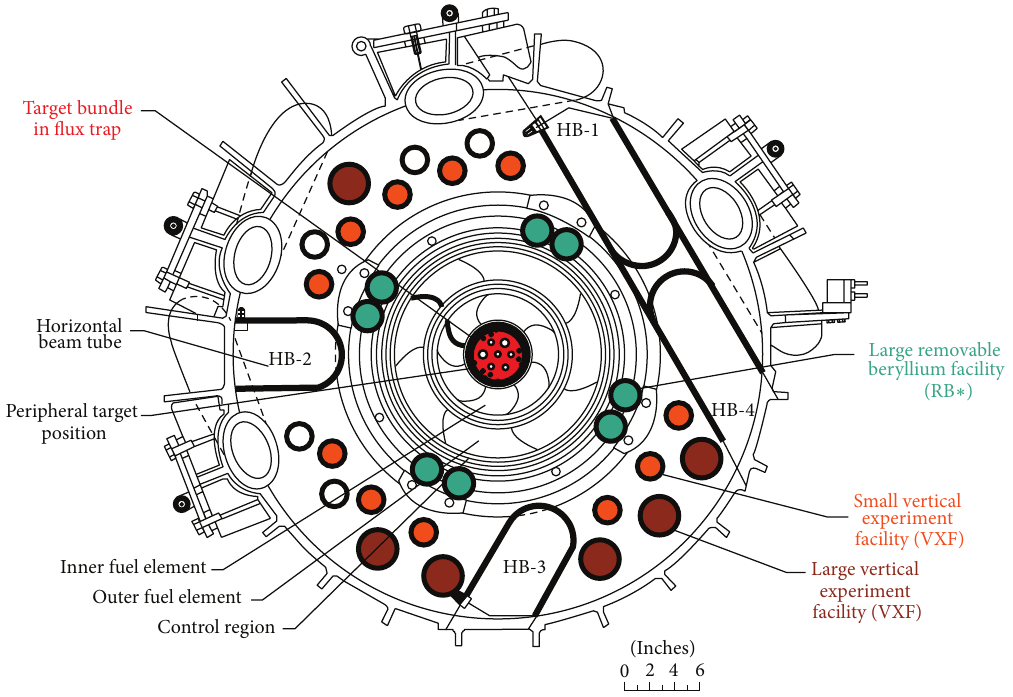
Figure 14: HFIR horizontal cross-section [11].